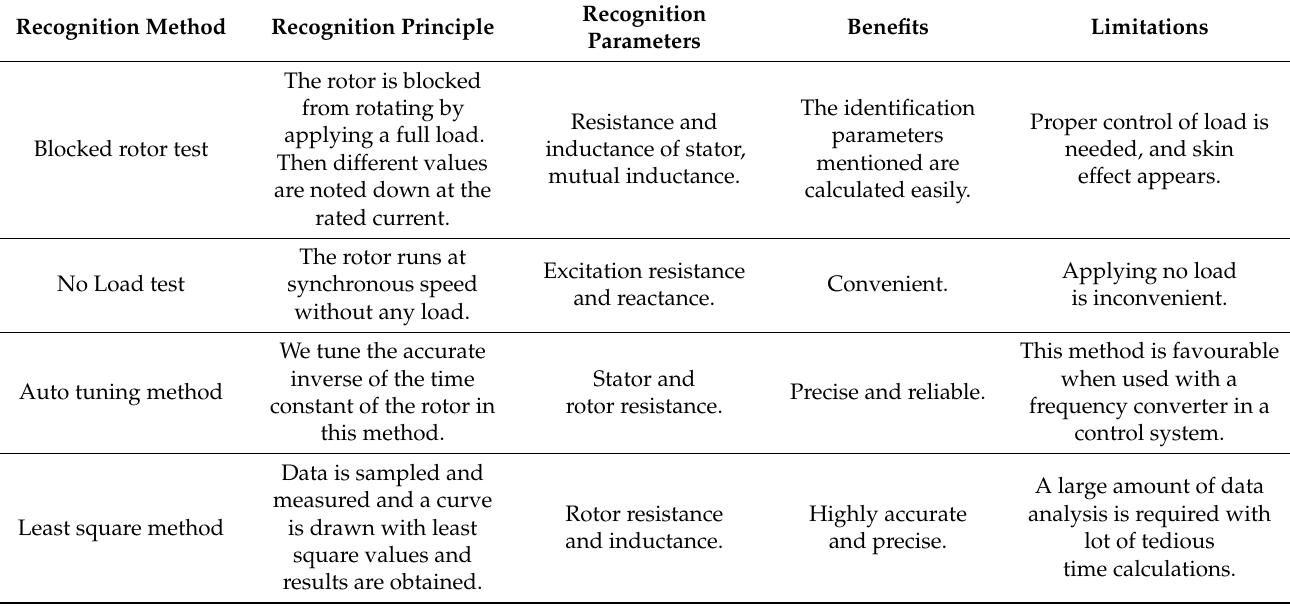
Table 2. Survey for parameter estimation—offline identification